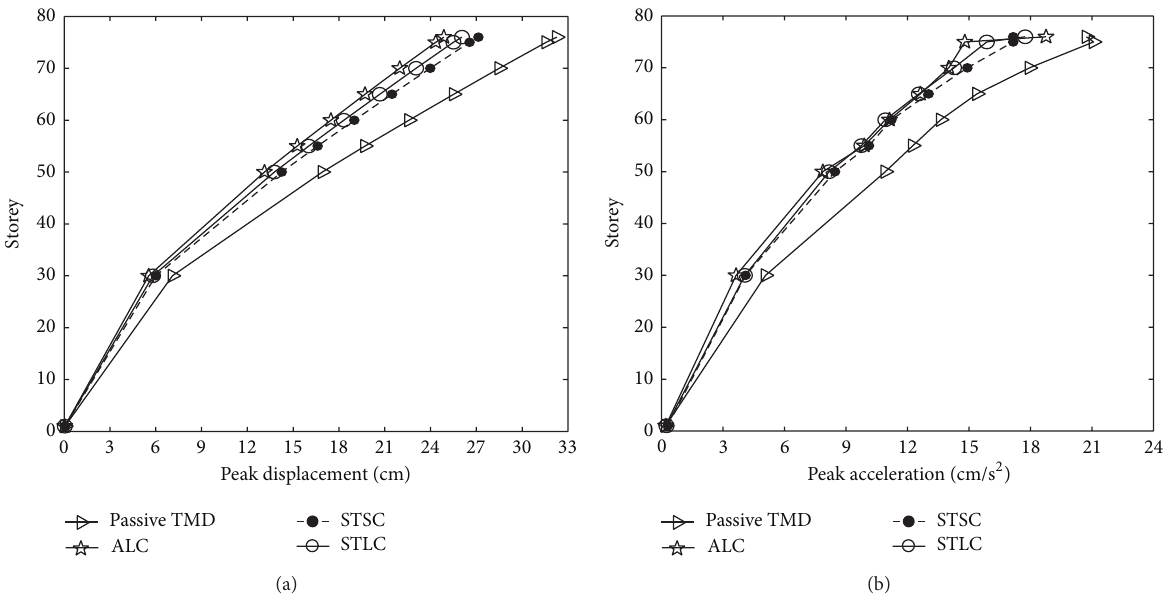
Figure 11: Comparison of peak displacement and peak acceleration ( −15 % stiffness variation).